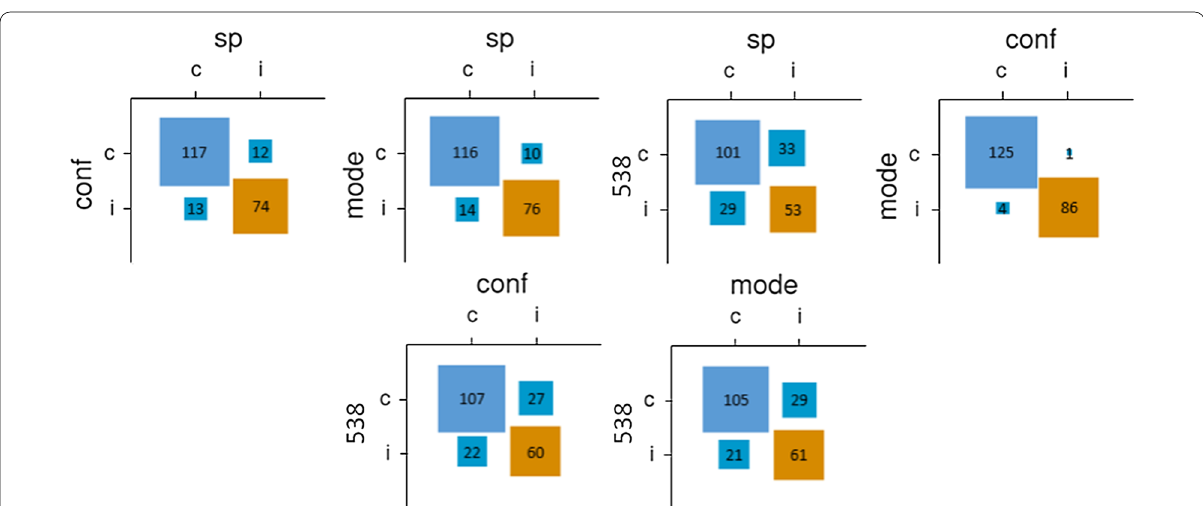
Fig. 2 Relationships between pairs of prediction methods for Study 1 (objectively assessed experts). Note sp conf confidence-weighted; mode =